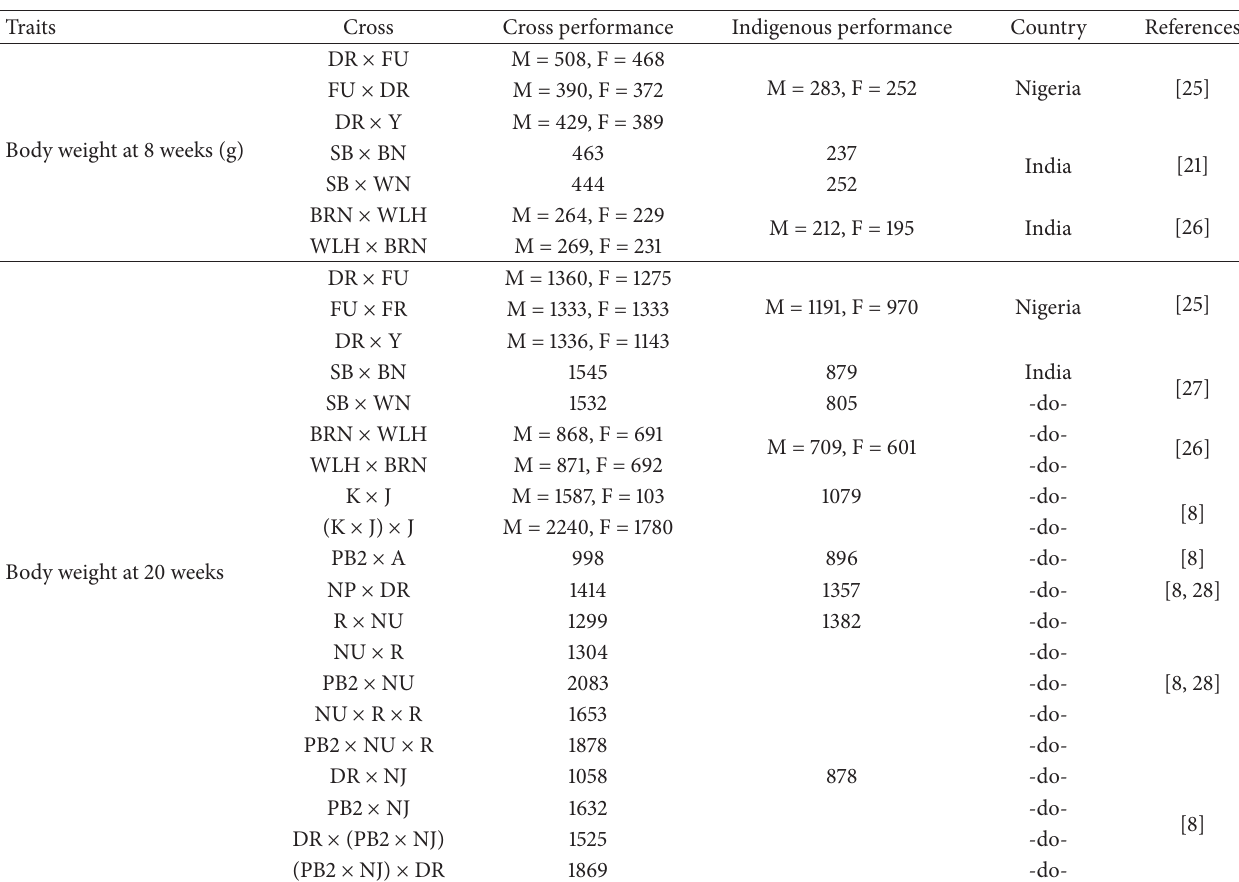
Table 2: Effect of crossbreeding using indigenous birds with respect to body weight at 8 and 20 weeks of age. Traits Cross Cross performance Indigenous performance